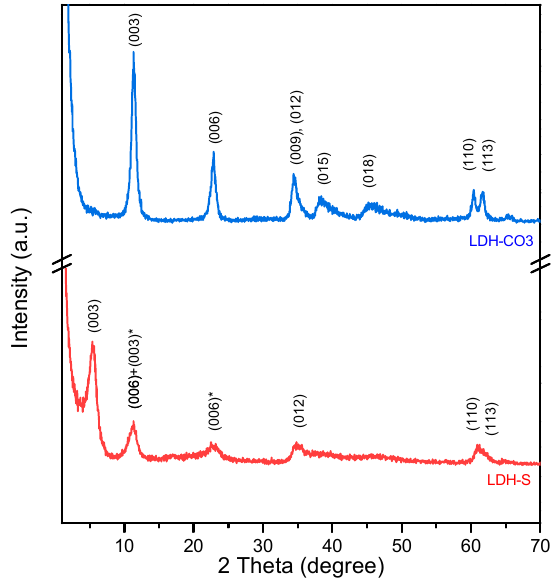
Figure 2. XRD patterns of LDH-CO 3 and LDH-S. * Peaks of the carbonate phase in LDH-S. The FT-IR spectra of LDH-CO 3 (Figure 3) shows a characteristic band at around 3500 cm − 1 , corresponding to the water molecules and free OH − groups stretching vibrations, the band at 1650 cm − 1 corresponding to the bending mode vibration of water molecules, and the band at 1375 cm − 1 of the carbonate antisymmetrical stretching mode. LDH-S spectra showed the most characteristic bands of fatty acid at around 1560 cm − 1 and 1460 cm − 1 due to antisymmetrical and symmetrical vibrations of carboxylate groups, respectively, as well as the C-H stretching vibrations at ~2900 cm − 1 and bending vibrations at ~1408 cm − 1 of the aliphatic chains. The absence of the protonated carboxylic group (-COOH) band of sebacic acid at ~1700 cm − 1 confirmed that this compound is intercalated in the interlayer in its anionic form.